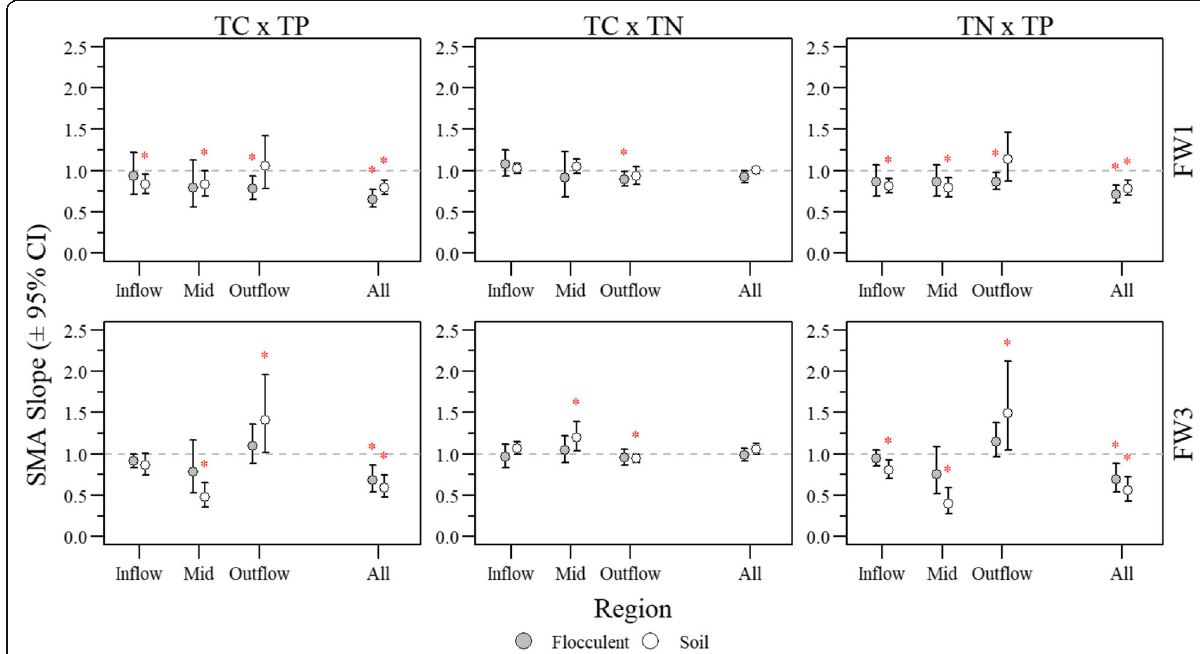
Fig. 9 Flocculent and soil inflow, mid, outflow, and overall standardized major axis slope values with ± 95% confidence interval for total carbon (TC), total phosphorus (TP), and total nitrogen (TN) comparisons. Slopes significantly different from one are identified with red asterisks above the upper 95% confidence interval